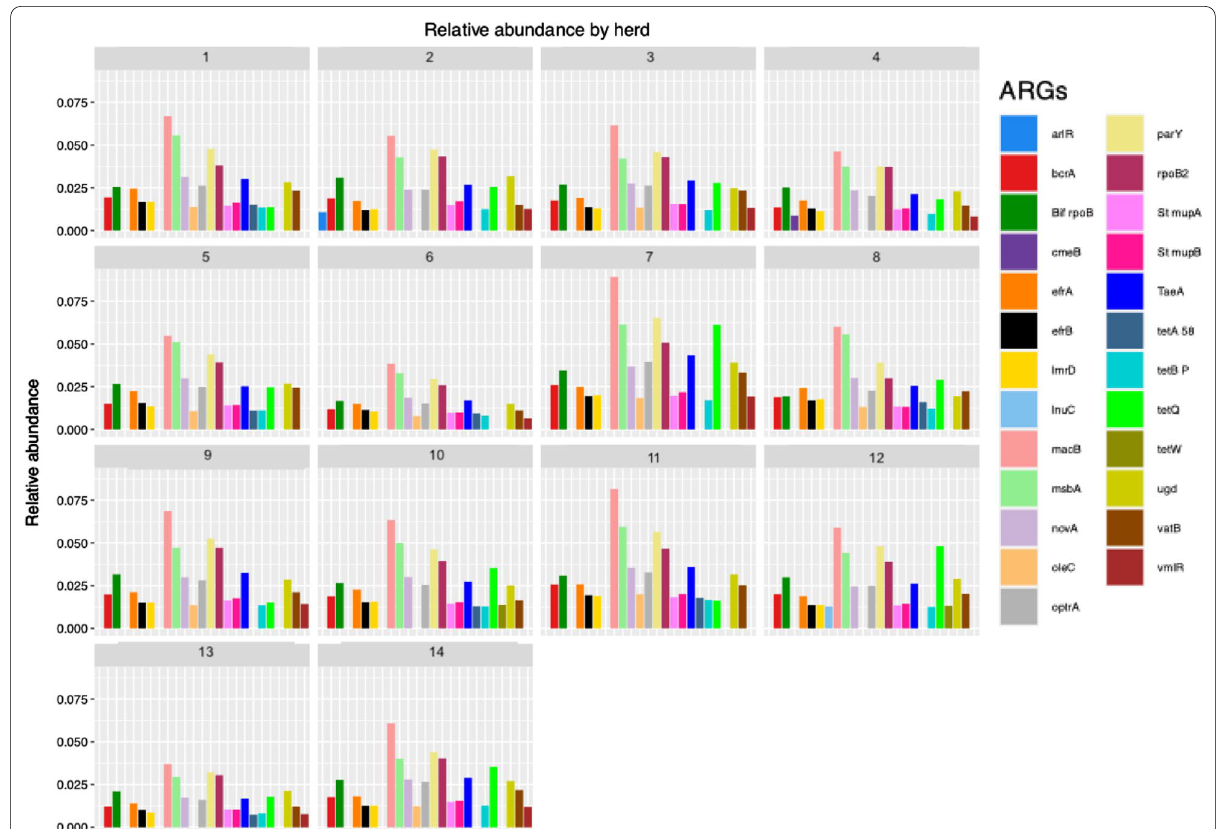
Fig. 1 Relative abundance (%) of ARGs by herd. Each box represents a different farm while each bar is the RA of a given gene